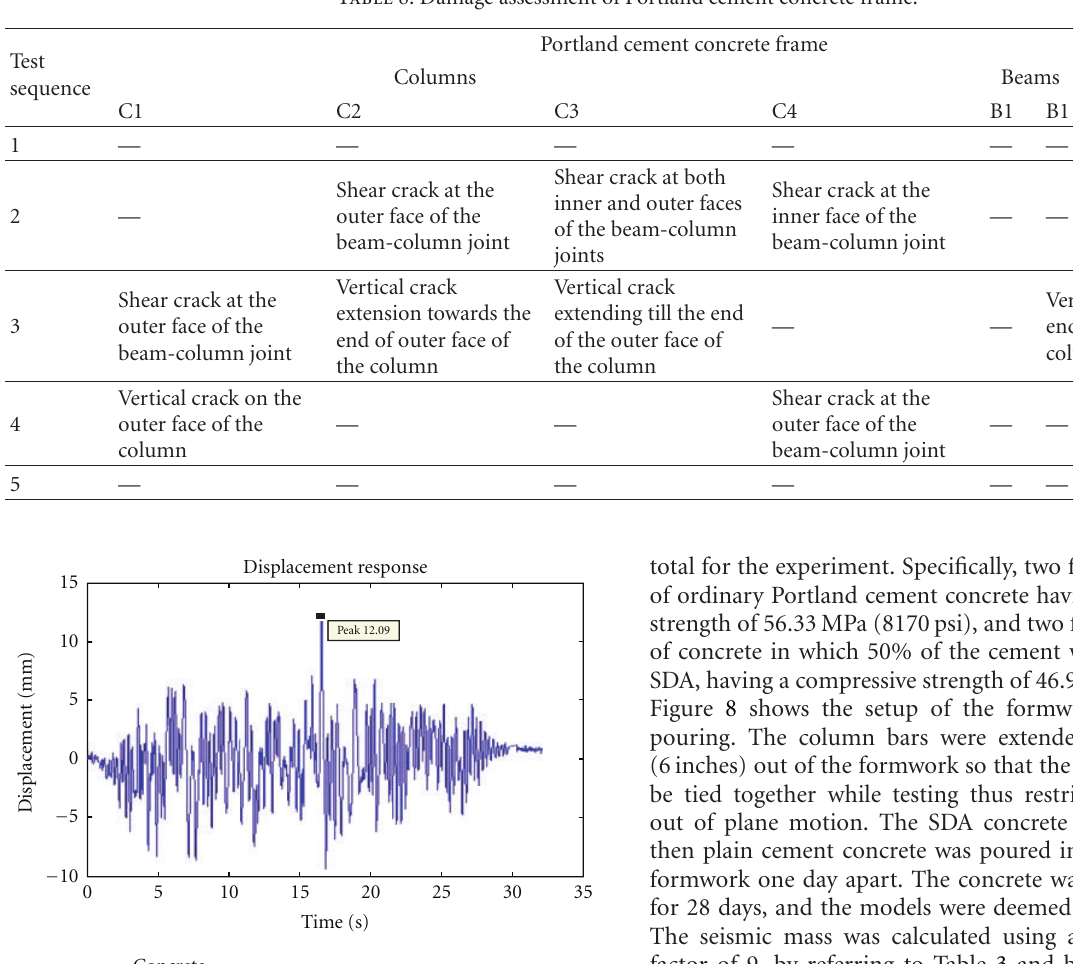
Table 8: Damage assessment of Portland cement concrete frame.